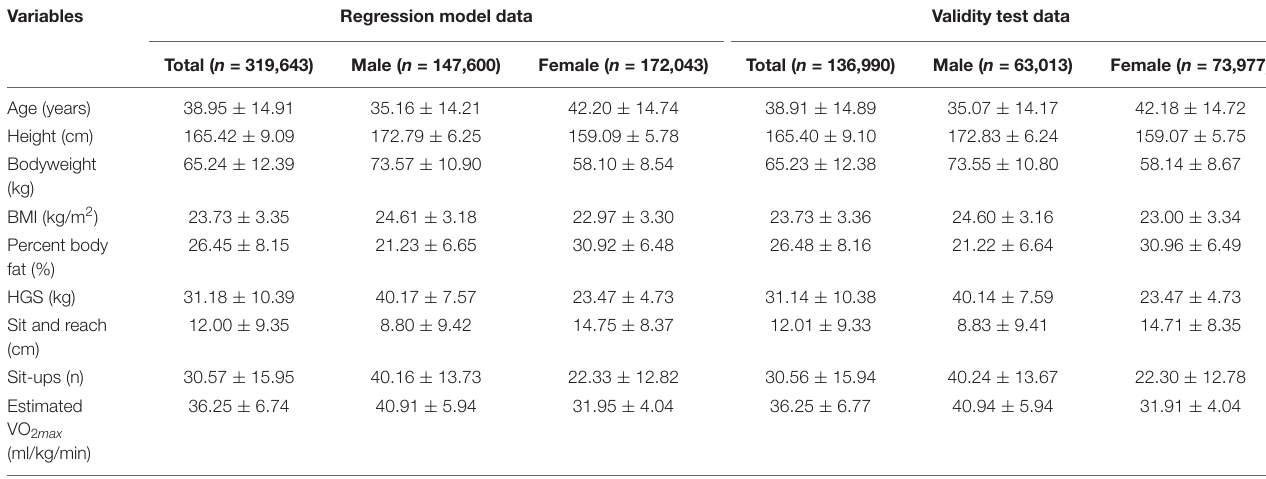
TABLE 1 | Characteristics of the study population. Variables Regression model